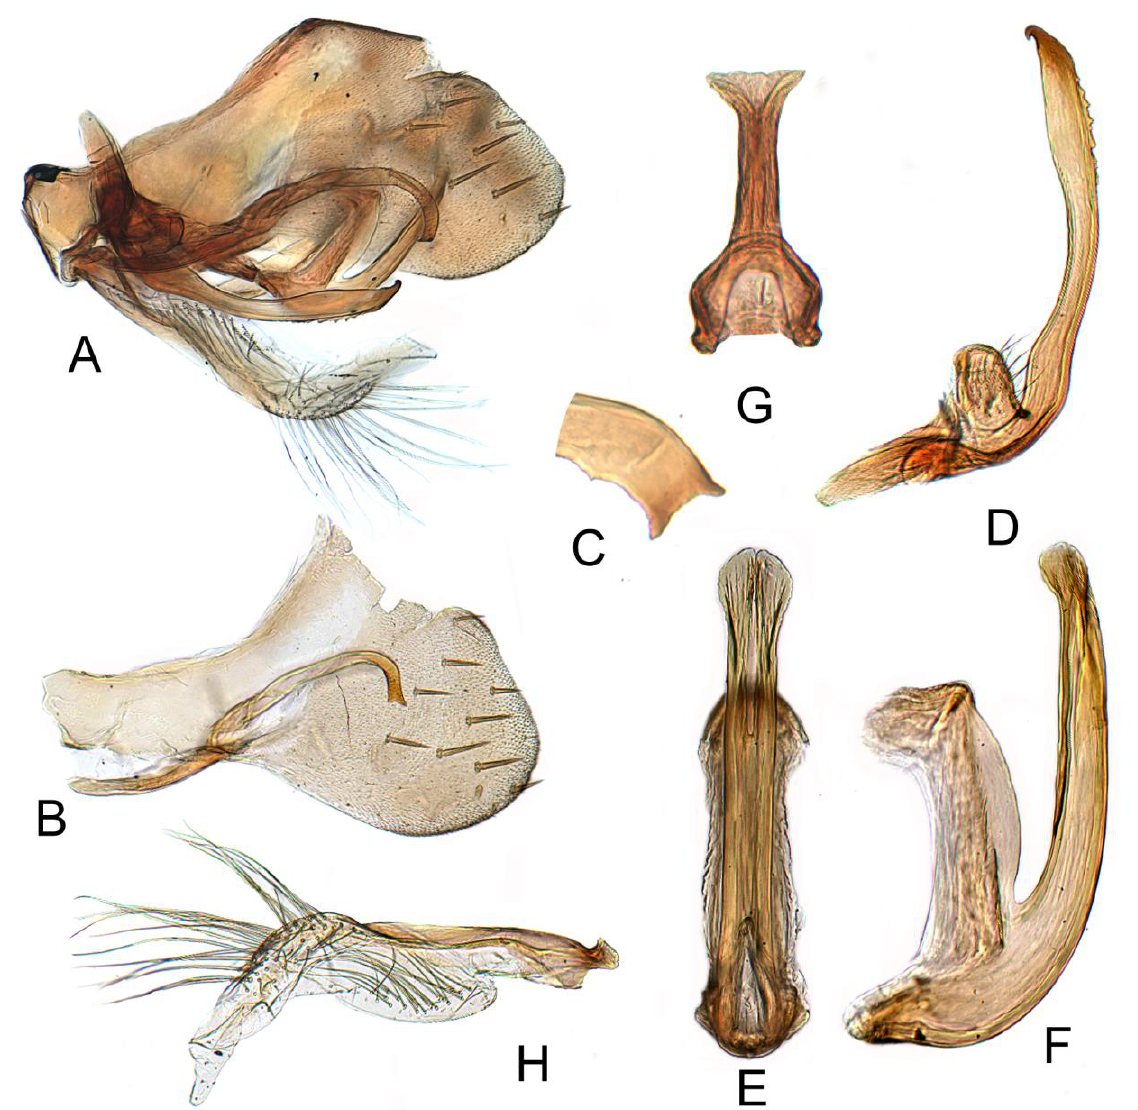
Figure 5. Batracomorphus allionii (Turton, 1802): ( A ) genital capsule in lateral view; ( B ) pygofer side; ( C ) pygophore processes apex; ( D ) styles; ( E ) aedeagus, ventral view; ( F ) aedeagus, lateral view; ( G ) connective; ( H ) sub-genital plate.